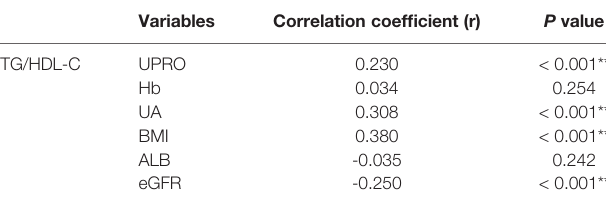
TABLE 2 | Correlation between related variables and TG/HDL-C.